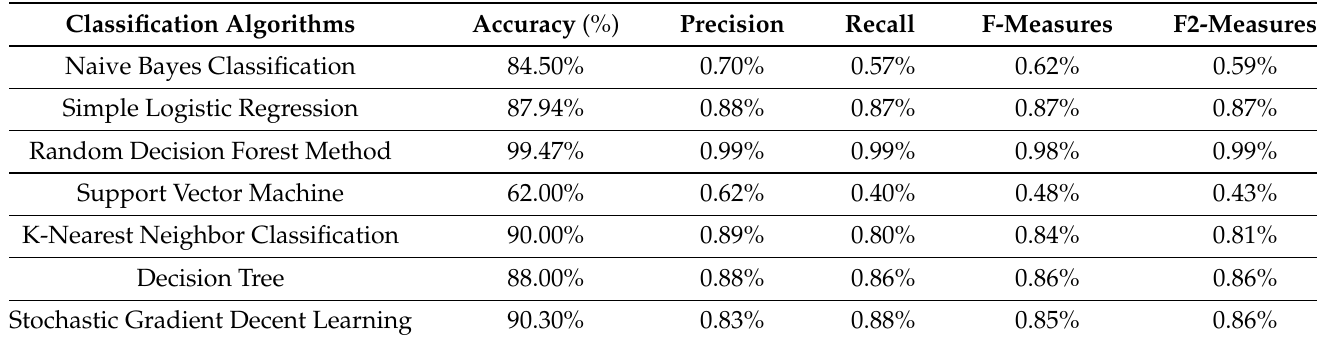
Table 1. Breast cancer diagnosis without data pre-processing.